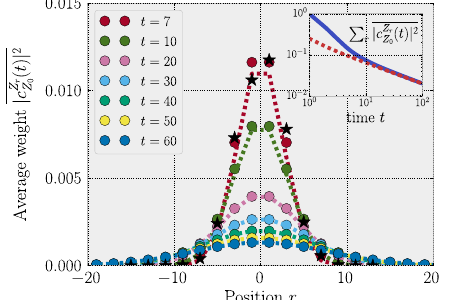
ˆ Z FIG. 7. Average weights of single-site operators j c Z r Z ð t Þj 2 0 (dots) compared to their lower bound given by the squares of the average coefficients ( j c Z r Z ð t Þj ) 2 (dashed lines). The weights 0 approach the lower bound at times t ≈ 10 . The weights are computed using the classical partition function formalism of Sec. IVA, and for comparison we show TEBD data averaged over 100 circuit realizations at time t ¼ 7 (black stars). Inset: The total ˆ Z weight contained in single-site operators decays in time at the rate set by the diffusion of the coefficients c Z r Z ð t Þ , as t − 1 = 2 at long 0